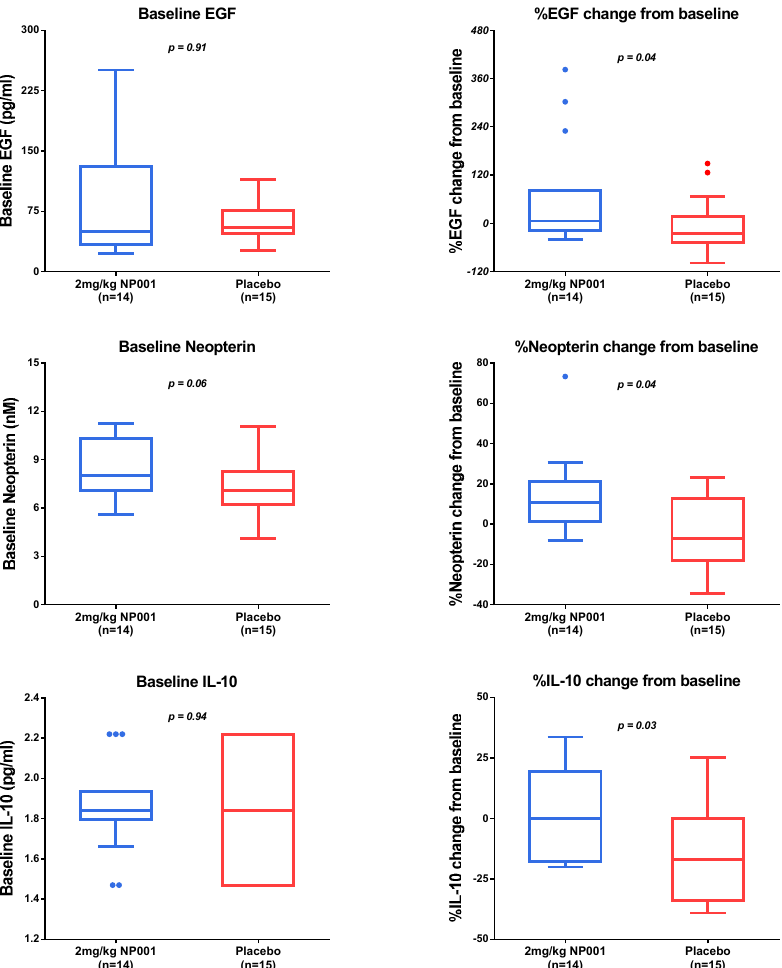
Figure 4. NP001-associated decrease in plasma biomarkers. Plasma biomarker levels at baseline (left column) and % change from baseline after 6 months (right column) in participants with plasma CRP > 1.13 mg/L in the phase 2A trial. Compared to the placebo group ( n = 15), the NP001-treated ( n = 14) group showed significantly lower levels over 6 months. The p -values are shown on the individual biomarker plots: (Wilcoxon test) p = 0.006 for LPS-binding protein (LBP), p = 0.04 for lipopolysaccharide (LPS), p = 0.03 for hepatocyte growth factor (HGF), p = 0.02 for IL-18 and p = 0.02 for soluble CD163 (sCD163).